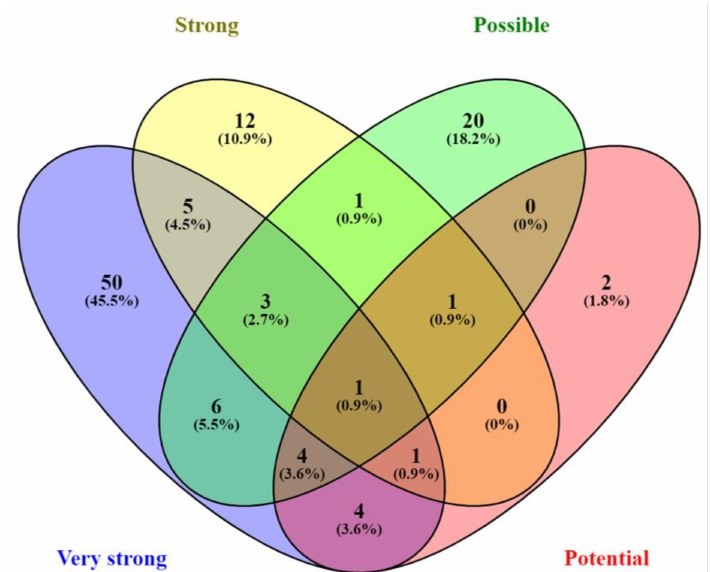
Figure 3. Overlap of common identified miRNAs between different candidate categories, according to the level of evidence.